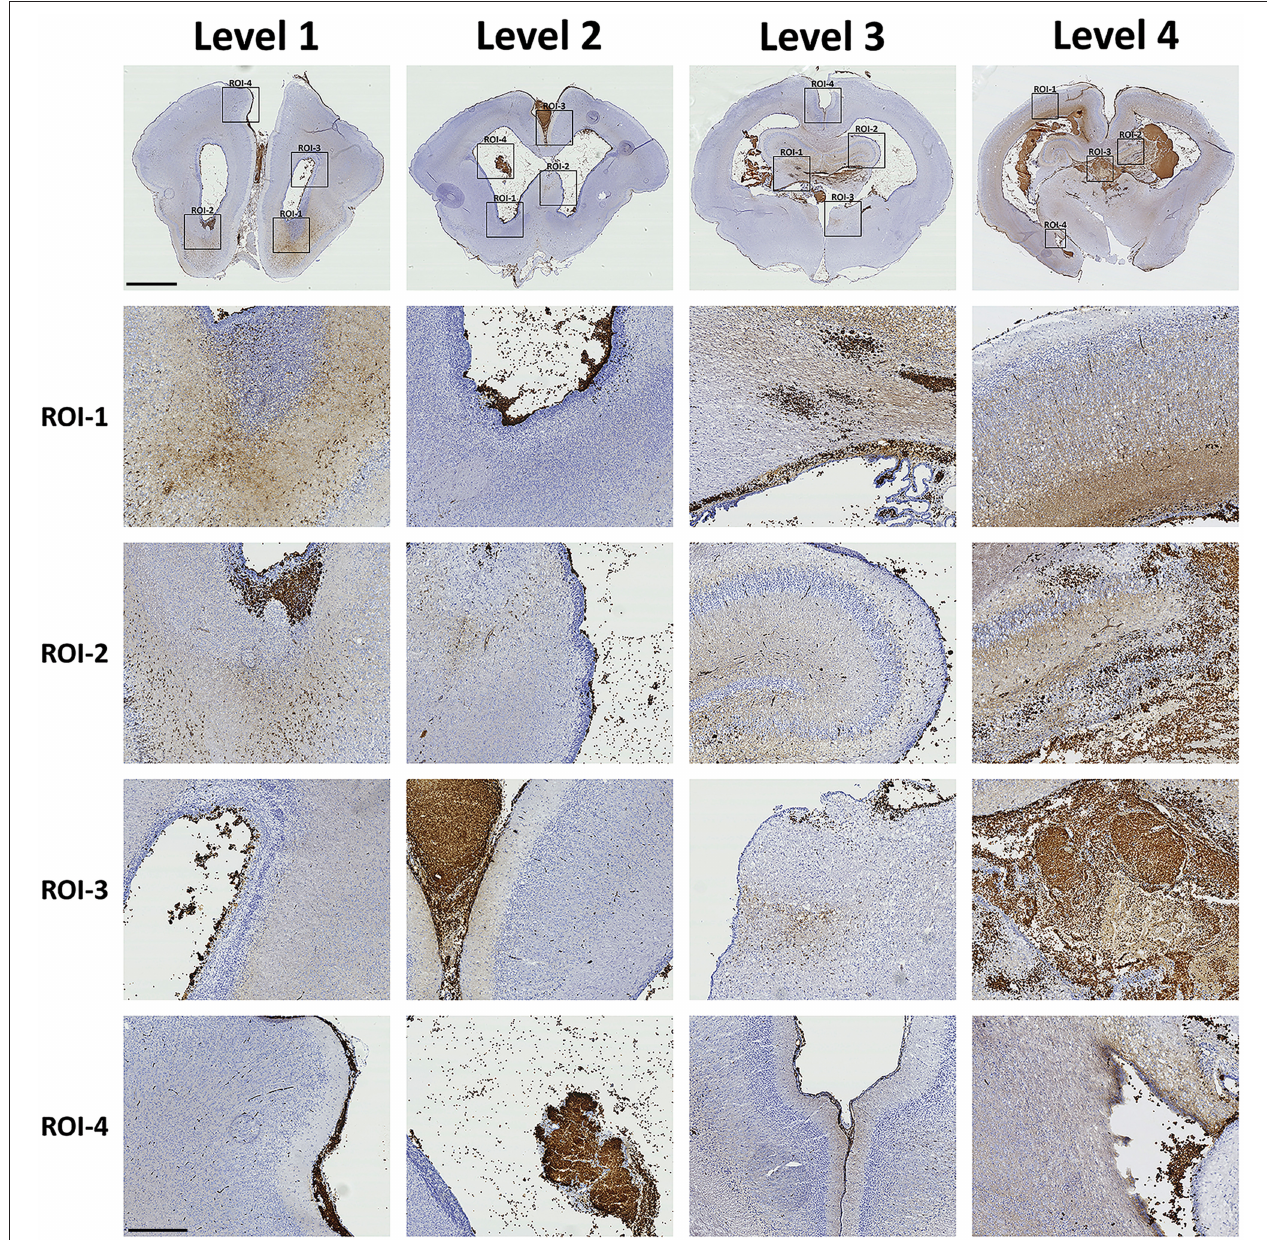
FIGURE 2 | Characterization of Hb following preterm rabbit pup IVH. The presence of Hb following IVH was characterized within the brain utilizing the inherent peroxidase activity of Hb. Rabbit pups with IVH or sham controls were euthanized at 72h of age followed by saline and freshly prepared 4% PFA perfusion. Afterwards the brains were dissected out from the skulls and immersed in 4% PFA. Brains were prepared and sections and a number of subventricular and periventricular anatomically comparable regions of interests (ROI) were chosen. Neuroanatomically defined ROI’s located in the rostral forebrain at the levels of rostral forebrain (Level 1), caudal forebrain (Level 2), rostral midbrain (Level 3) and caudal midbrain (Level 4), were stained for peroxidase activity of Hb as described in the Materials and Methods Section. Microscope analyses were performed on a wide-field Olympus microscope (IX73) and slide scanning were performed on a Hamamatsu NanoZoomer 2.0-HT Digital slide scanner: C10730. Scanning was performed with a 40 × magnification lens. Images used for illustrations, from regions of interest (ROI), were grabbed with the viewer software NDP.view2 Viewing software. Scale bar of slide scan image indicate 2.5mm and of ROI images indicate 500 µ m.